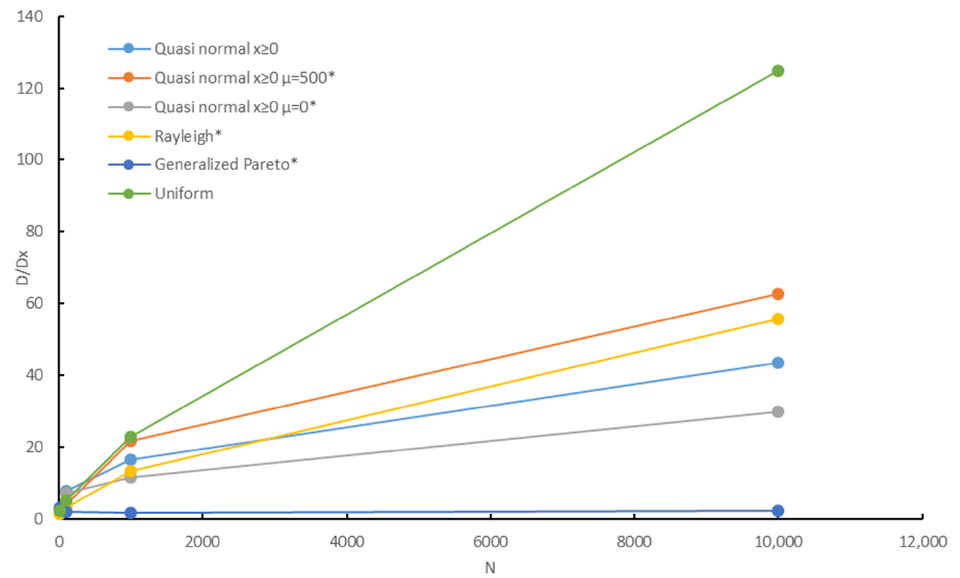
Figure 4. Dependence of the maximum delay estimate on the sample size for minimum service curve β (cid:48) , N is a sample size. The symbol * means the data is measured in a real computational environment; the data without * are generated with a random number generator.